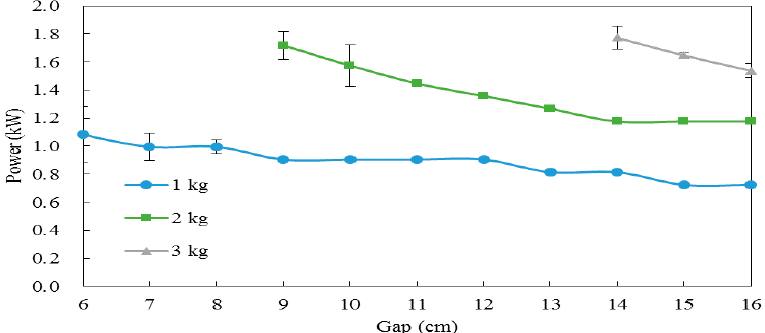
Figure 1. The radio frequency (RF) power output at different electrode gaps on 1, 2 and 3 kg rice bran packages. Data are expressed as the mean ± SD ( n = 3).